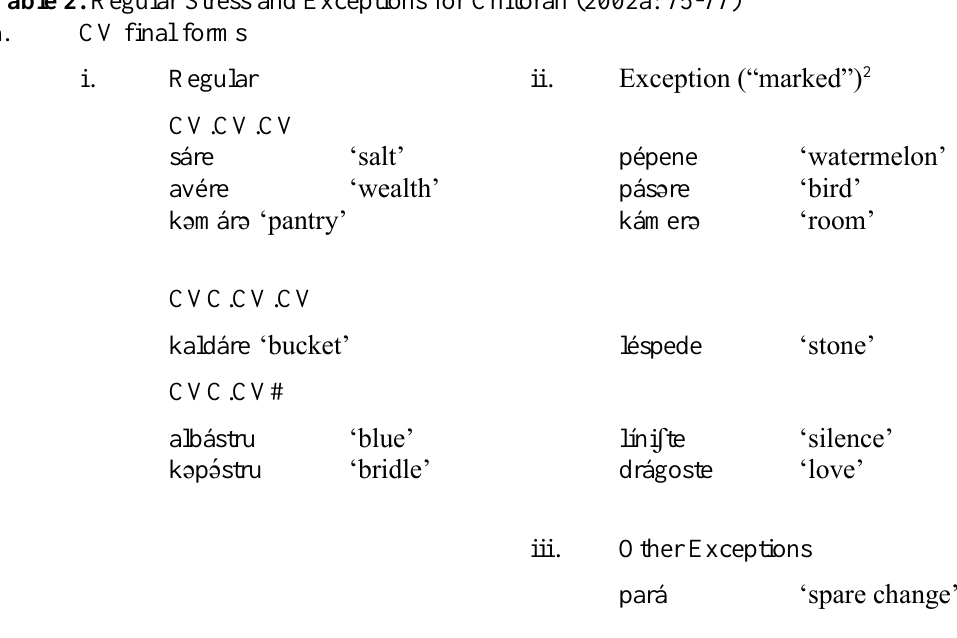
Table 2. Regular Stress and Exceptions for Chitoran (2002a: 75-77)